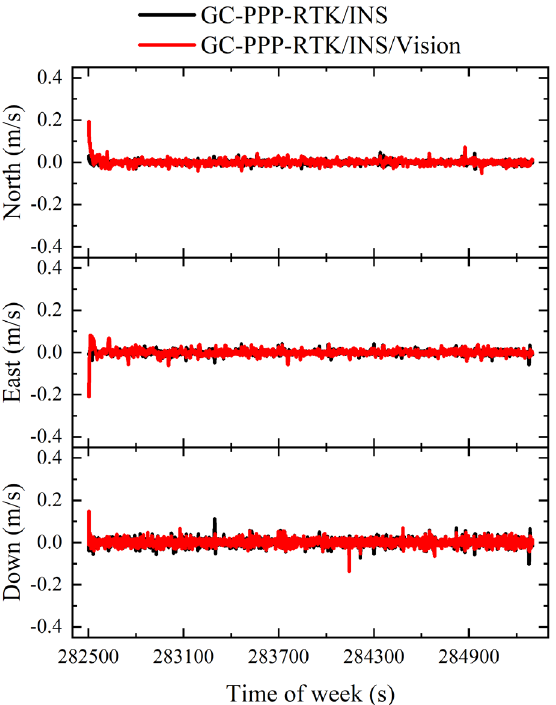
Figure 12. Velocity error series of GC-PPP-RTK/INS and GC-PPP-RTK/INS/vision for T01.